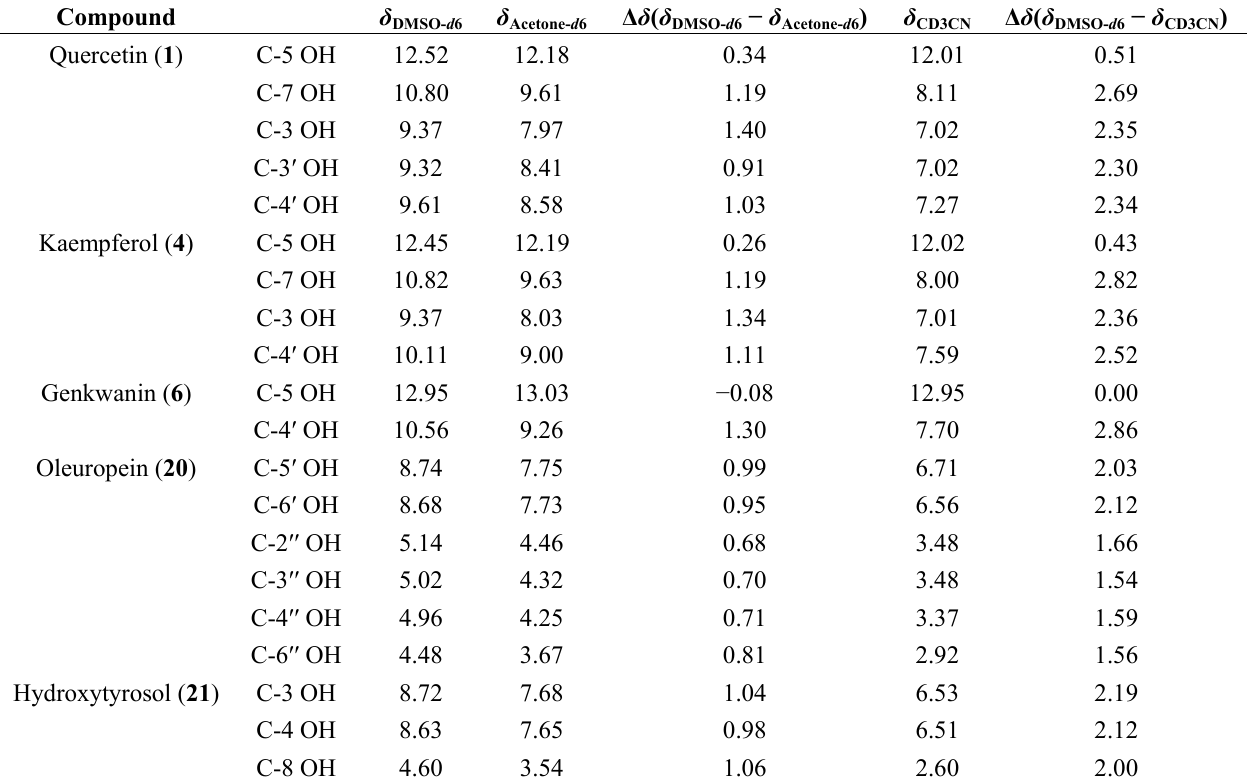
Table 3. Chemical shifts of hydroxyl protons of quercetin ( 1 ), kaempferol ( 4 ), genkwanin ( 6 ), oleuropein ( 20 ), and hydroxytyrosol ( 21 ) (Table 2) in DMSO- d and their differences at 298 K